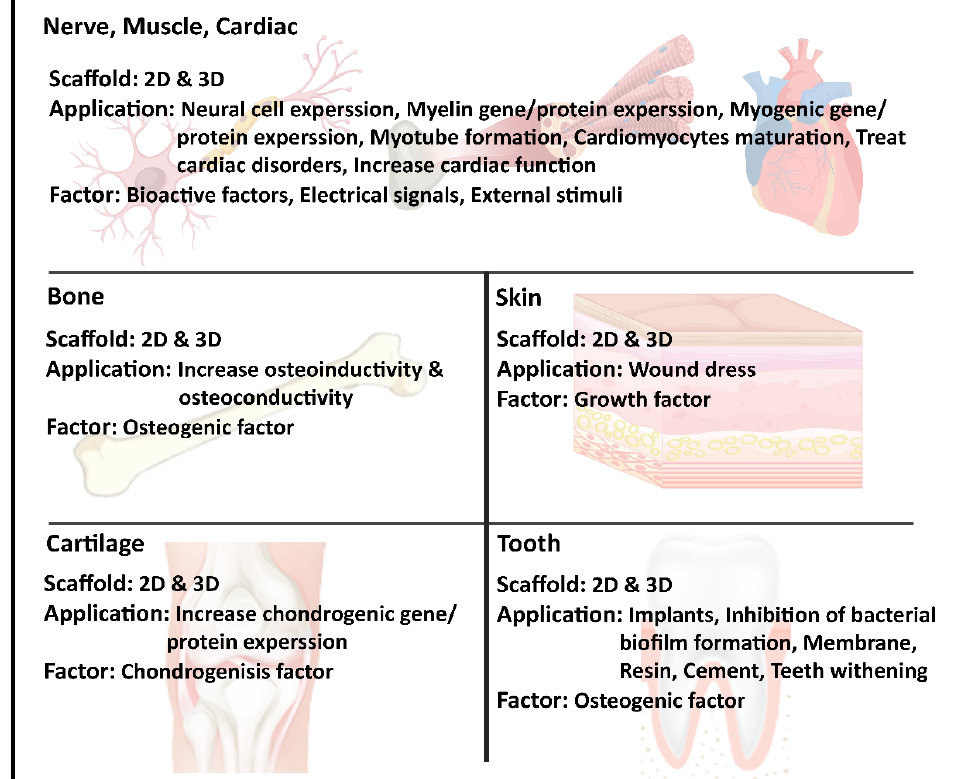
Figure 7. Graphical conclusion.